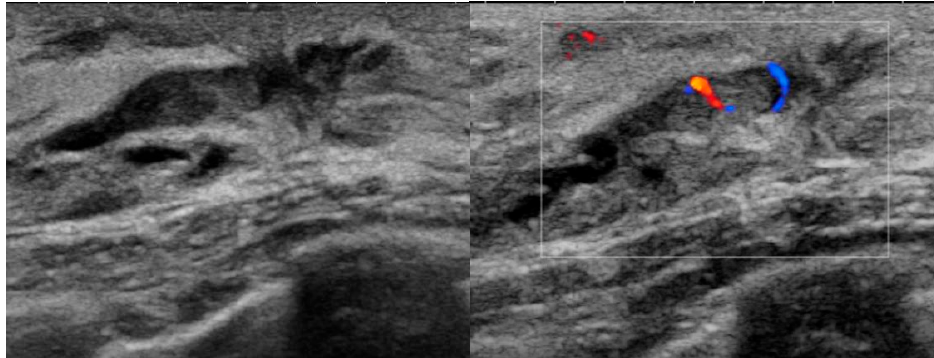
Figure 2. A 38-year-old woman presented with bloody nipple discharge. ( a ) Ultrasound shows a 1.0 cm isoechoic intraductal mass with internal blood flow in the left breast subareolar area. Benign intraductal papilloma was confirmed on pathology after surgical excision. Ductal change was the only significant factor associated with PND in the multivariate Table 6. Multivariate logistic regression analysis to determine the risk factors associated with path- ologic nipple discharge in papillary breast lesions. Variable Odds Ratio (95% CI) p -Value Ductal change 5.083 (1.180–21.894)